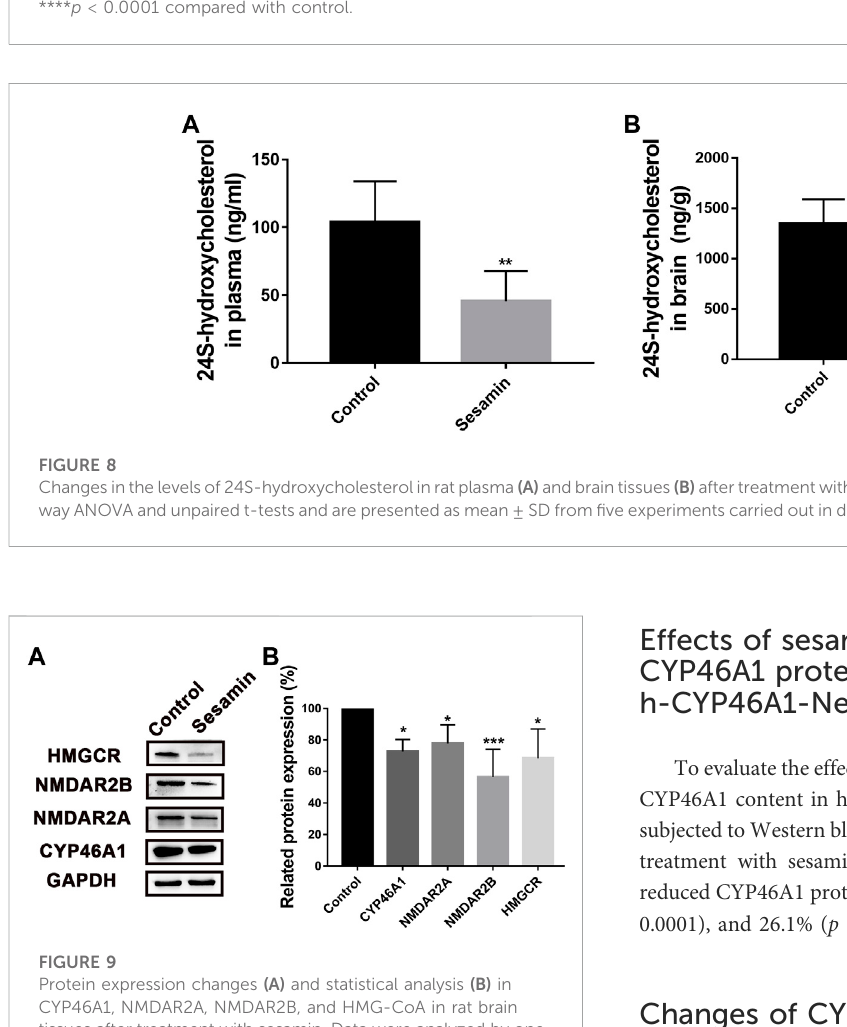
FIGURE 9 Protein expression changes (A) and statistical analysis (B) in CYP46A1, NMDAR2A, NMDAR2B, and HMG-CoA in rat brain tissues after treatment with sesamin. Data were analyzed by one- way ANOVA and unpaired t-tests and are presented as mean ± SD from fi ve experiments carried out in duplicate. * p < 0.05, *** p < 0.001 compared with